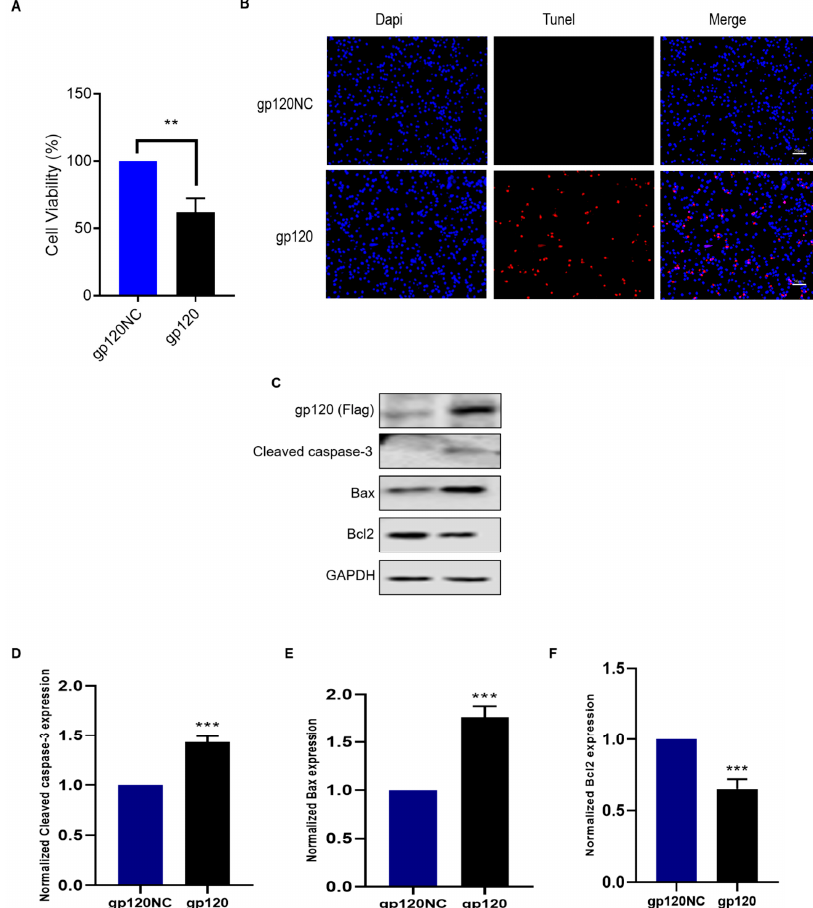
Figure 2. ( A ) After 48 h of PC12 transfection with gp120 plasmid and its co-corresponding empty vector, CCK8 was carried out; the statistical analysis between treatment and control group was ** p < 0.01, t -test. ( B ) TUNEL assay and DAPI stains were used to detect apoptotic cells, as shown in the immunofluorescence images. DAPI labeling of nucleic acids was used to observe the intact cell nu- clei, while TUNEL staining of fragmented DNA was used to mark apoptotic cells. ( C ) Expression of Cleaved caspase-3, Bax, and Bcl2 levels mediated by gp120 were measured and the protein levels were normalized by GAPDH and quantified by Image J. ( D – F ) The expression level was statistically assessed using t -test, *** p < 0.001, n = 3.